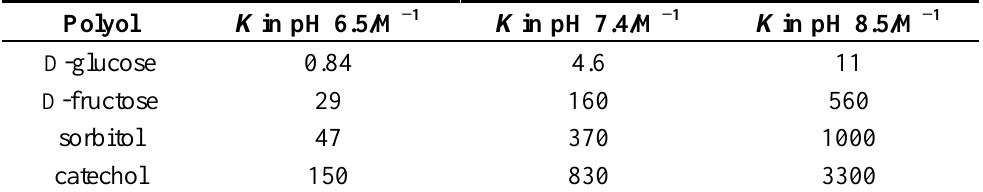
Table 1. The binding constants of phenylboronic acid to polyol compounds in 0.1 M of phosphate